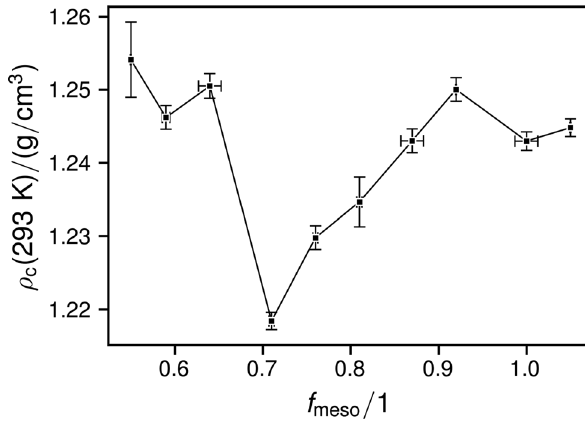
Figure 12: Relative free volumes V V free hc / ( squares and full lines ) together with their vibrational V V free:vib hc / ( circles and dashed lines ) and excess contributions V V free:exs hc / ( triangles and dotted lines ) at 428 K.